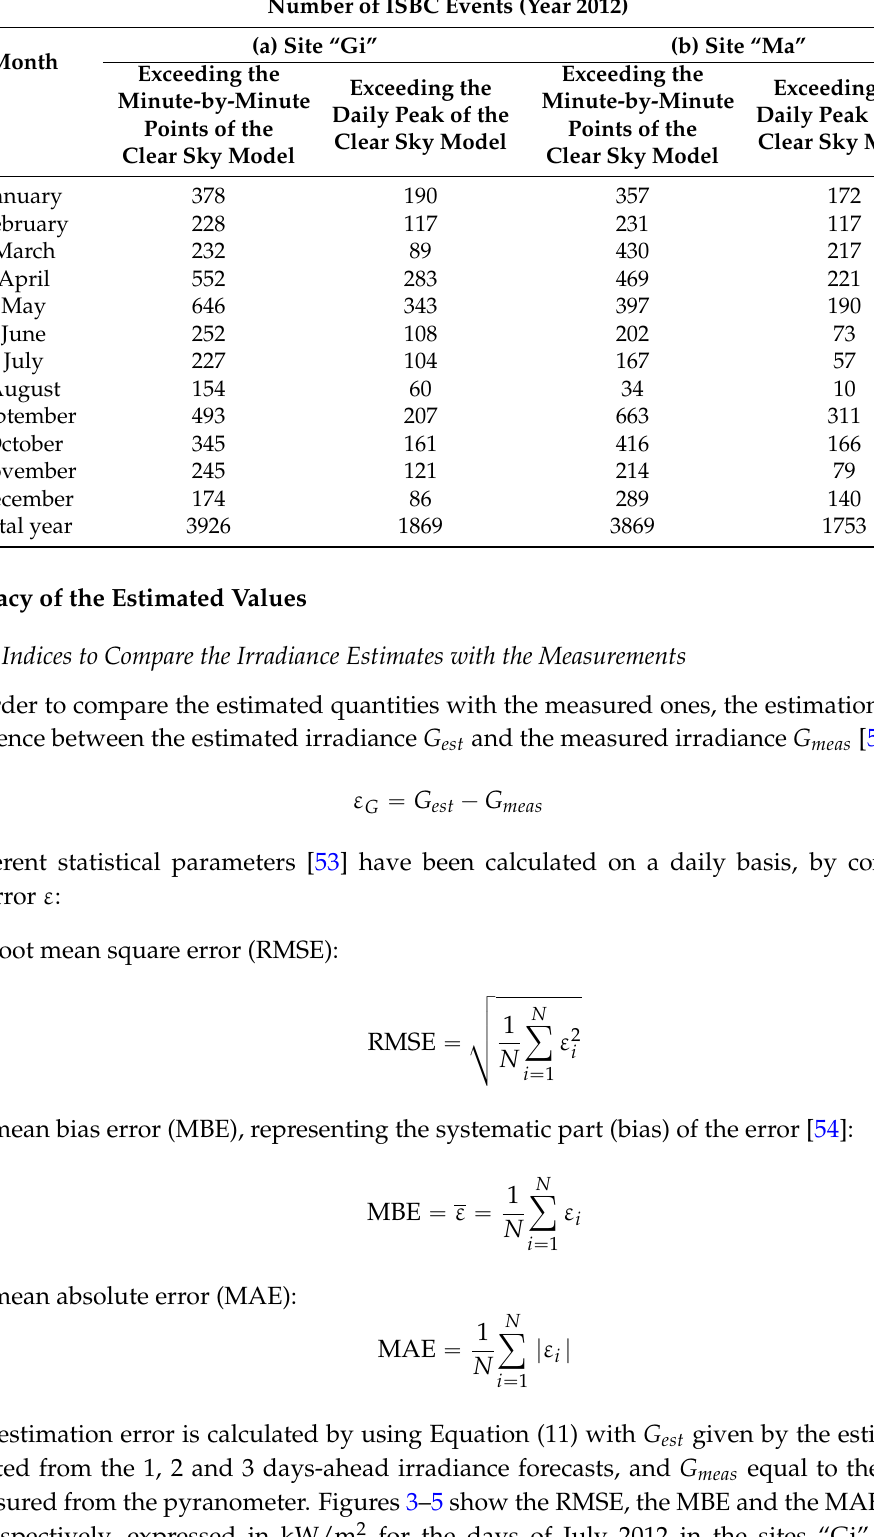
Table 5. Number of ISBC events for each month, considering G tcell with time step of 1 min, exceeding the minute-by-minute points and the daily peak of the clear sky model. Number of ISBC Events (Year 2012) Month Exceeding the Exceeding the Exceeding the Exceeding the Minute-by-Minute Minute-by-Minute Daily Peak of the Daily Peak of the Points of the Points of the Clear Sky Model Clear Sky Model Clear Sky Model Clear Sky Model January 378 190